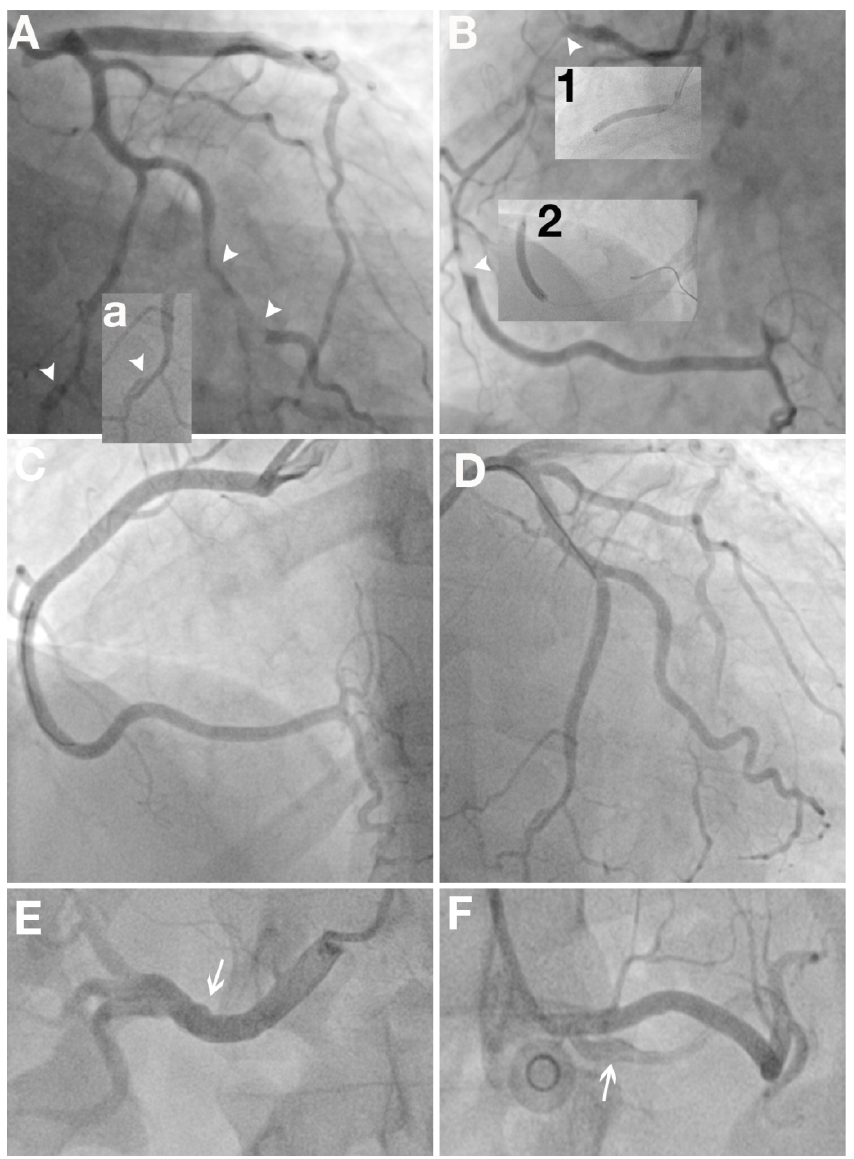
Figure 5. Multivessel SCAD in a 45 years old female patient with inferior ST segment elevated myocardial infarction. A —coronary angiography—SCAD (white arrowheads) on left circumflex artery ( a ) and obtuse marginal artery (OM); B —coronary angiography—long SCAD (white arrowheads) on righ coronary artery (RCA); 1 and 2 —SCAD PCI strategy—distal and proximal stent implantation to stop progression of the dissection; C and D —very good post PCI result on RCA and OM; E and F —right and left renal arteries with FMD aspect (white arrows). Due to continuous intense angina, we did not perform OCT.